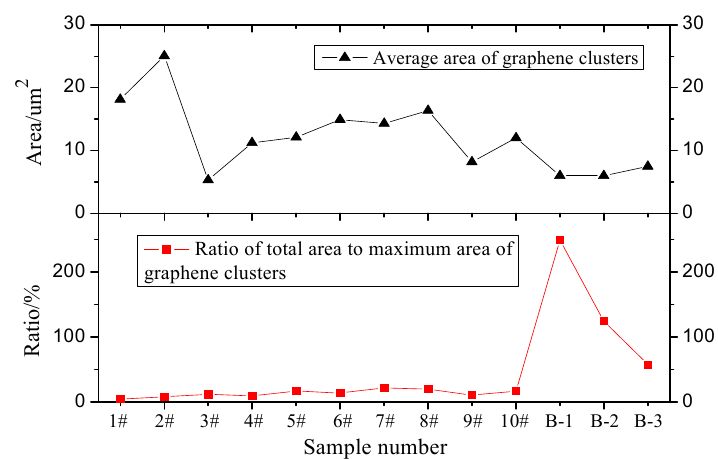
Figure 9. Variation trend of graphene cluster average area and ratio of total area to maximum area of graphene clusters.